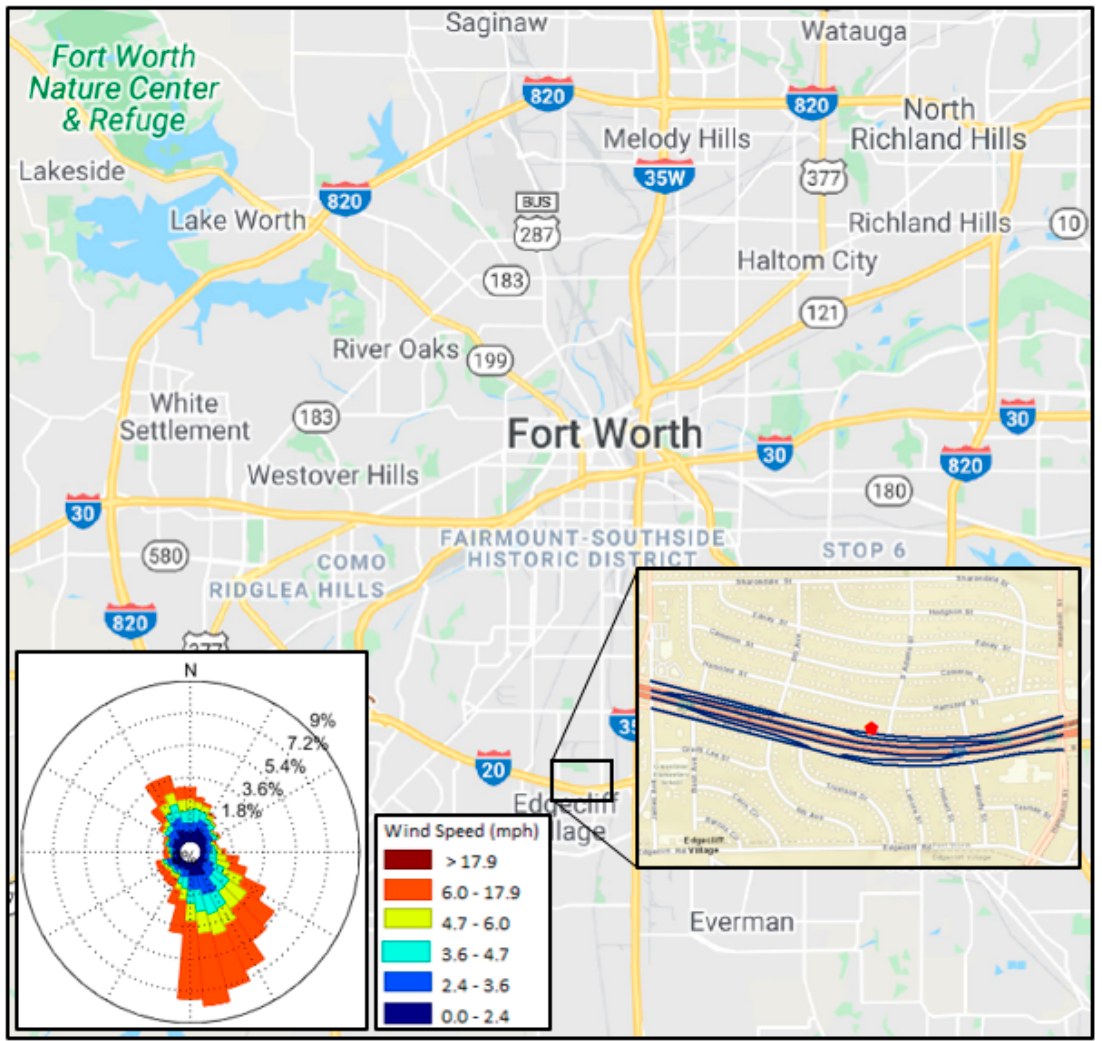
Figure 1. Study area (I-20: Ronald Reagan Memorial Highway shown by navy lines), near-road environment (shown by red mark) and corresponding wind rose based on monitored values in Fort Worth, Texas.